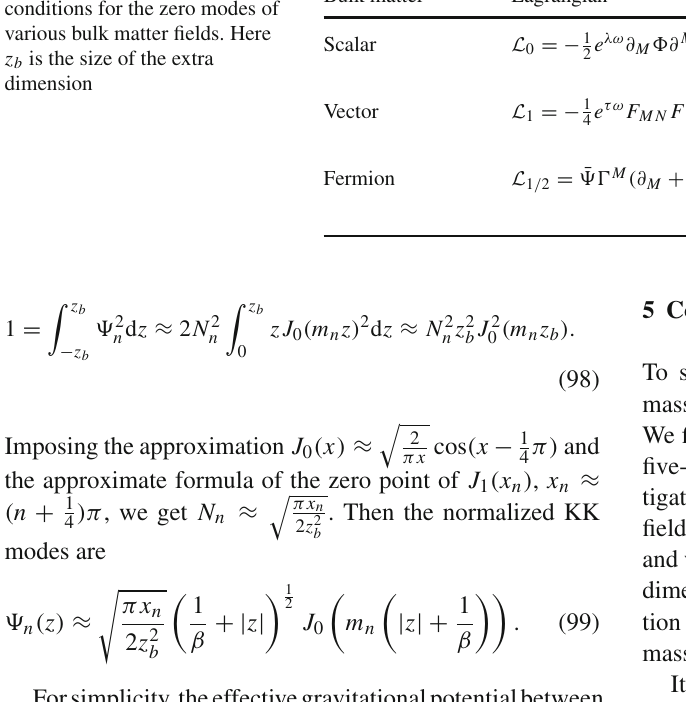
conditions for the zero modes of various bulk matter fields. Here z b is the size of the extra